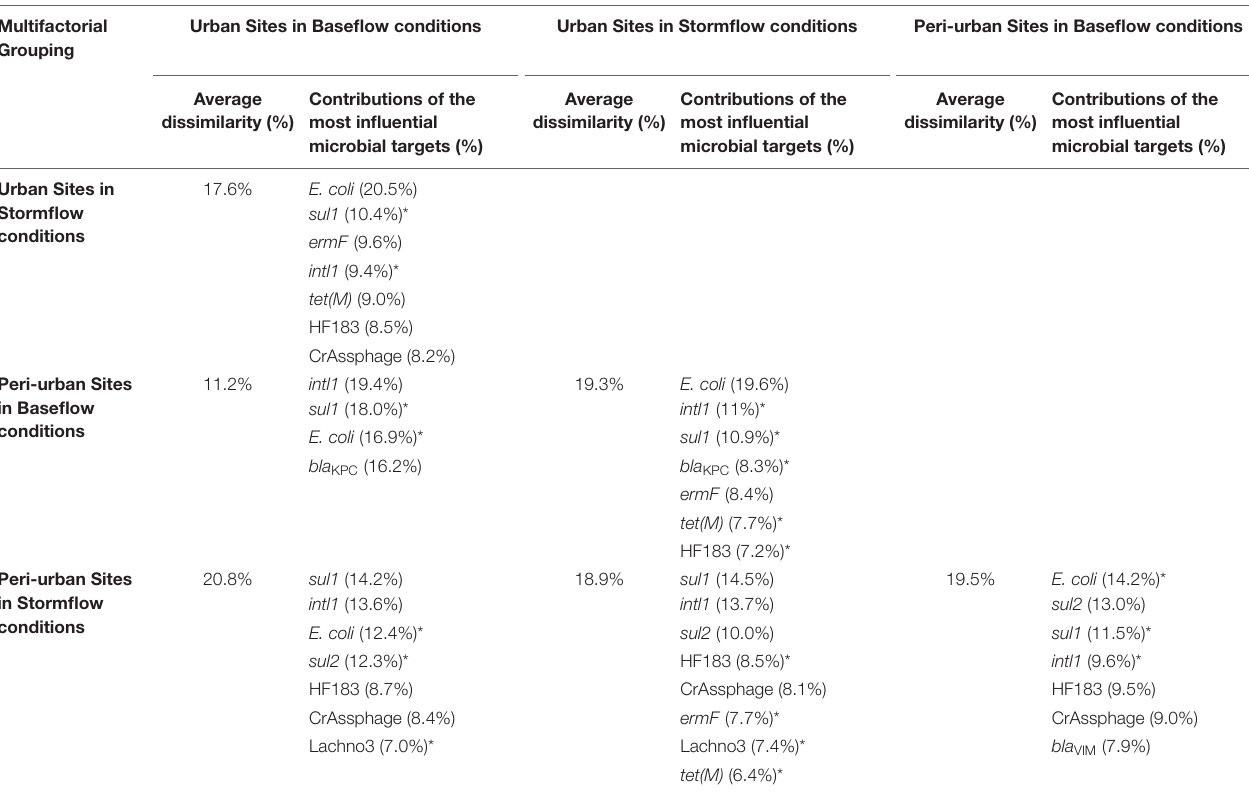
TABLE 1 | The average percent dissimilarities and the corresponding percent contributions of the most influential (explaining > 70% of the differences) microbial targets ( E. coli , sewage-associated markers, and ARGs) observed between the multi-factorial groupings (flow condition and site type) for river water samples, as identified by the Similarity Percentages (SIMPER)